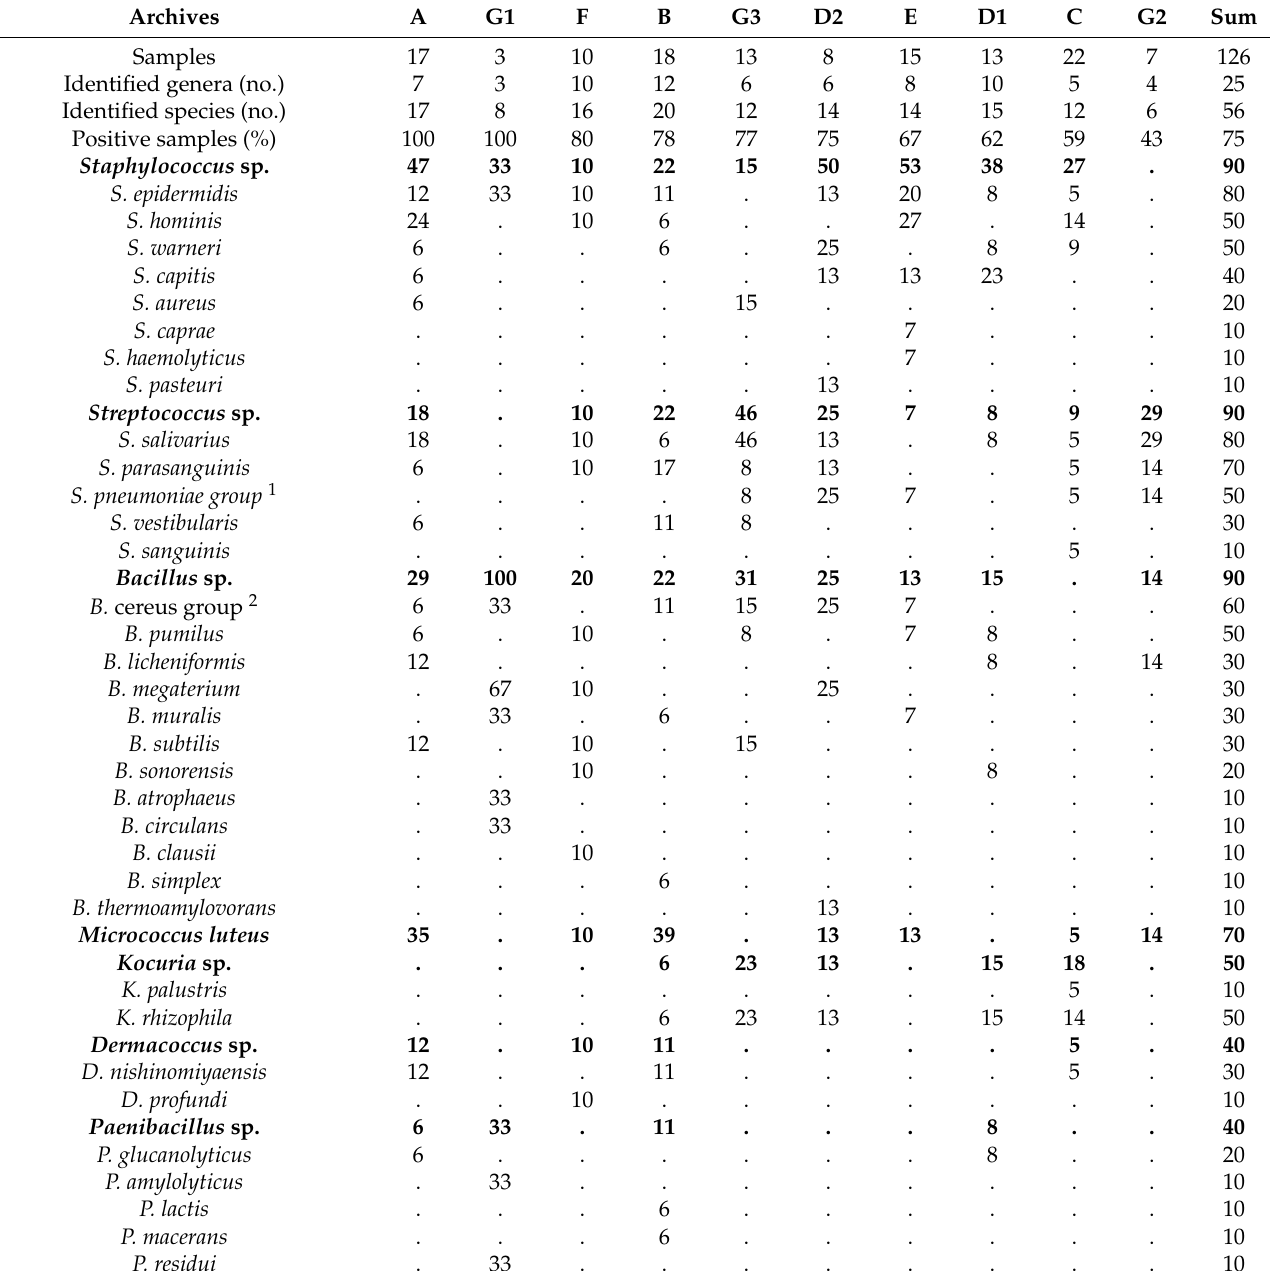
Table 2. The frequency of bacterial contamination (for present genera and species) from single archives regarding the percentages of samples positive for bacterial contamination (CFU ≥